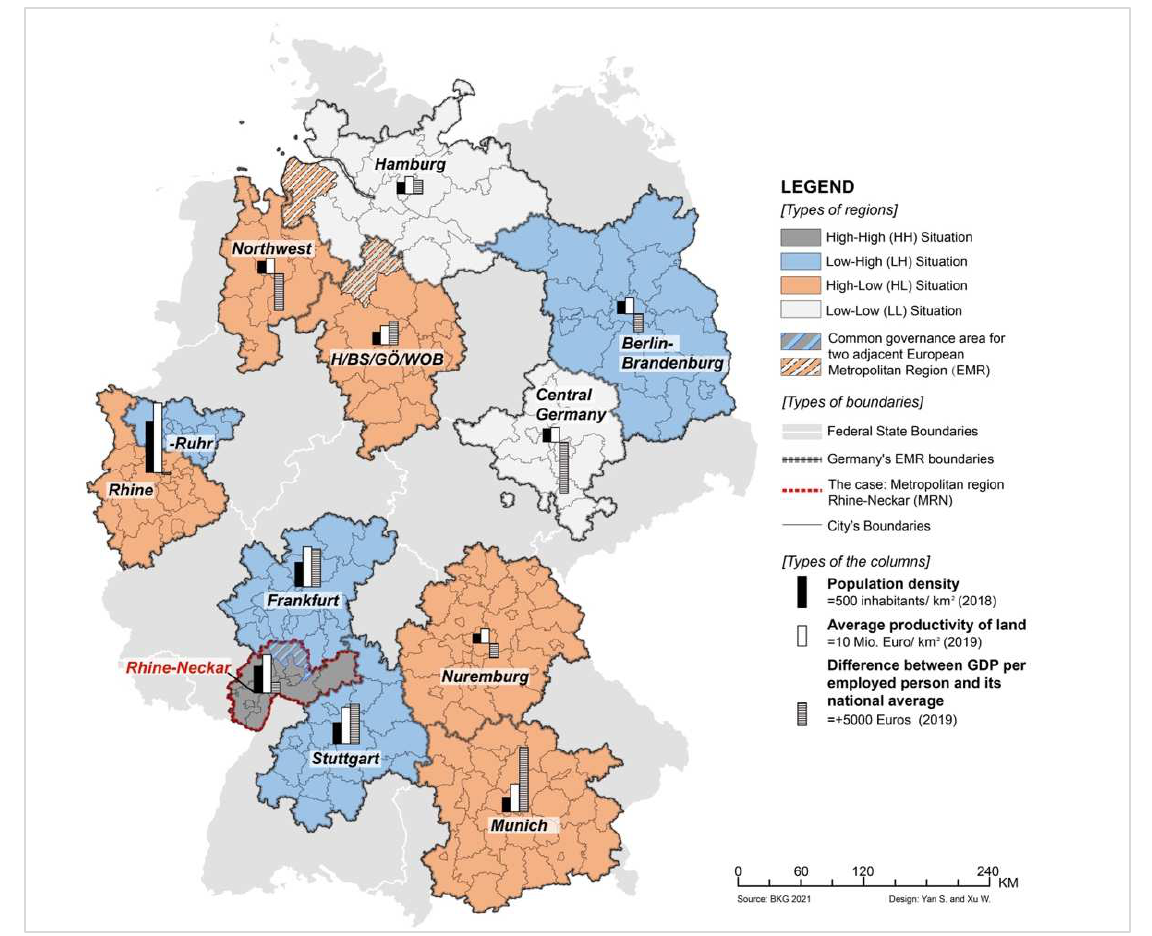
Figure 3. Spatial distribution of four types of governance situations and the comparison of EMRs in Germany. Source: Amended by authors based on GeoBasis-DE/BKG 2021 and 2022 Regional Monitoring of Initiativkreis Europäische Metropolregionen in Deutschland (https://deutsche-metropolregionen.org/ (accessed on 11 October 2022)).